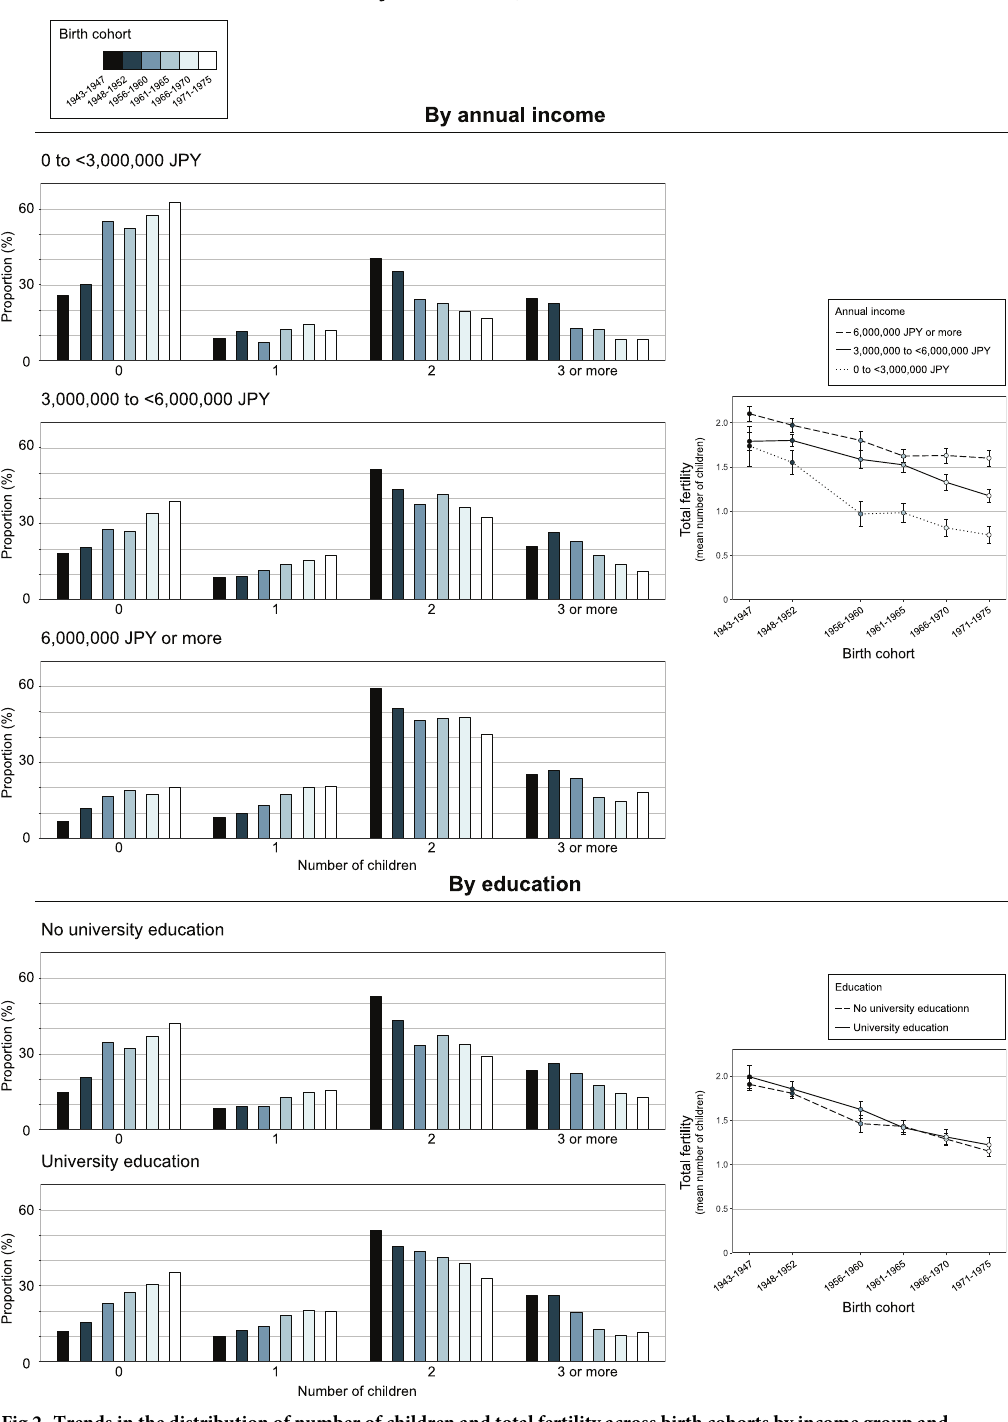
Fig 2. Trends in the distribution of number of children and total fertility across birth cohorts by income group and education in men.